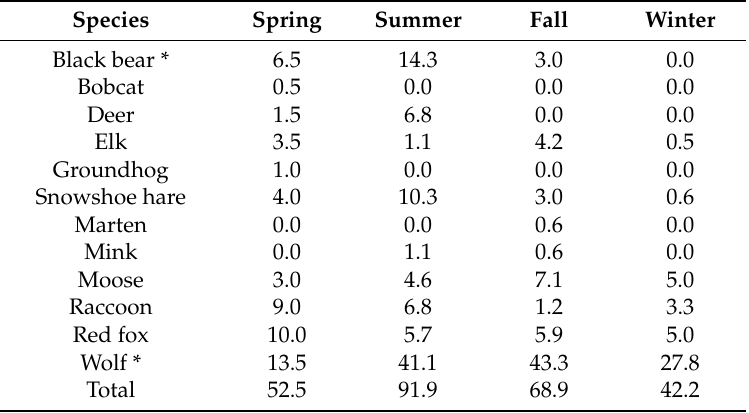
Table 1. Mean number of seasonal camera capture events of mammals per 10 km of railway for one year (2015 to 2016). Species Spring